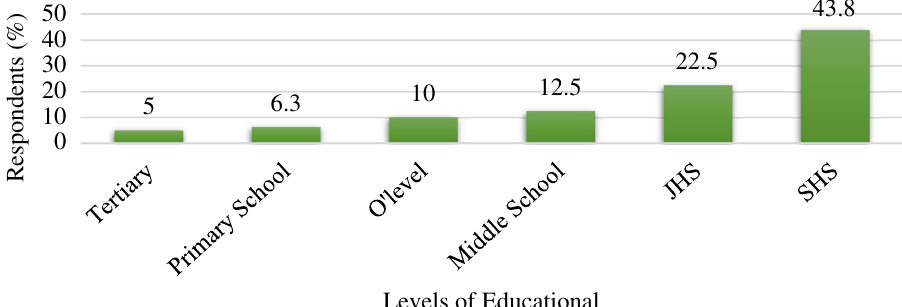
Figure 2. Educational History of